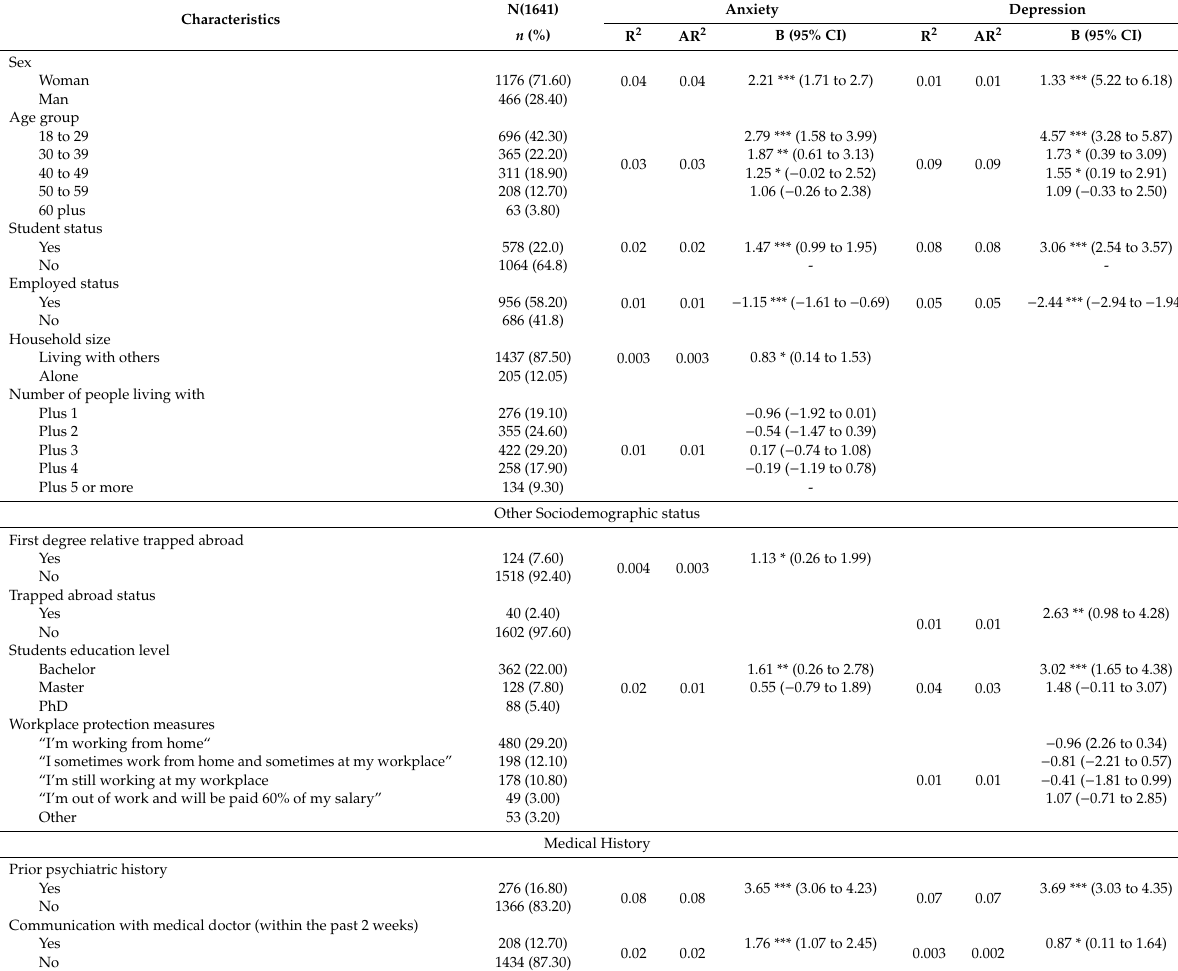
Table 3. Association between statistically significant variables with anxiety and depression